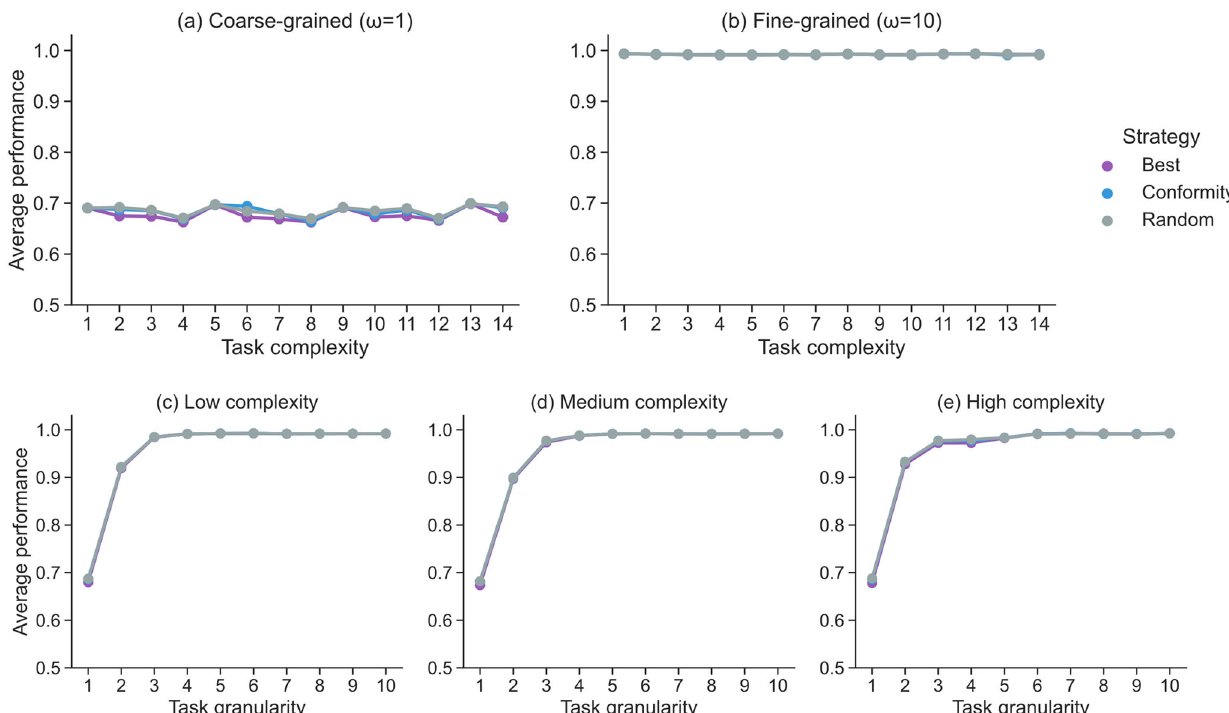
Fig. 2 Performance of groups using different strategies in hard-to-easy tasks. Two panels in the fi rst row show the results in a coarse-grained and b fi ne- grained hard-to-easy tasks with different complexity. Three panels in the second row show the results in hard-to-easy tasks with c low, d medium, and e high complexity. Purple lines: the best strategy. Blue lines: the conformity strategy. Gray lines: the random strategy. Based on a fully connected network with N = 100 individuals and the normal SQB